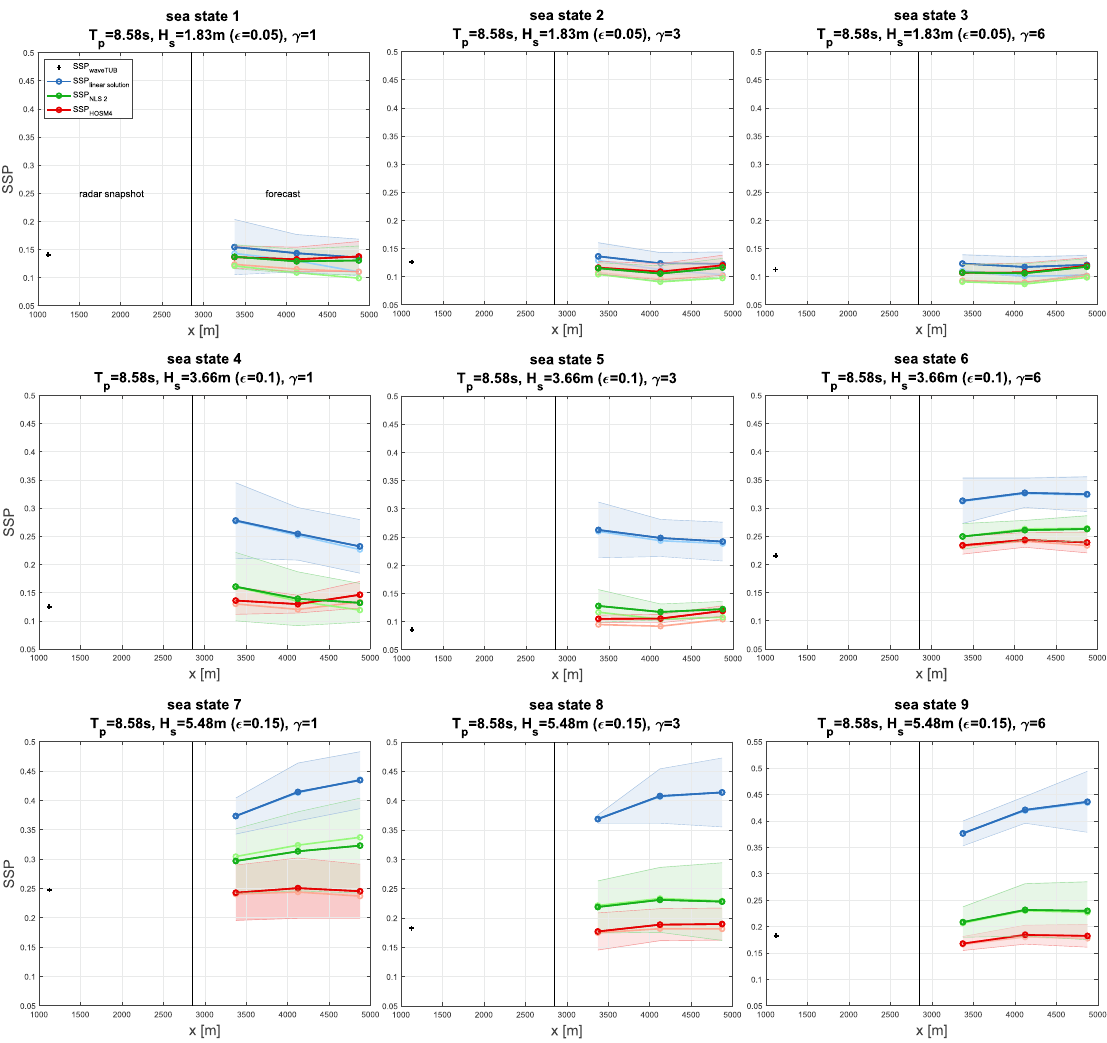
Figure 4. Surface Similarity Parameter for the investigated sea states at the three wave gauges for HOSM (red curves), second-order NLSE (green curves) as well as linear (blue curves) simulations in space domain. The darker illustrated curves represent the prediction accuracy including the radar shadow and the lighter illustrated curves display the accuracy without radar shadow. The dots on the curves illustrate the positions of the three wave gauges. The SSP of the waveTUB input snapshots is illustrated as black